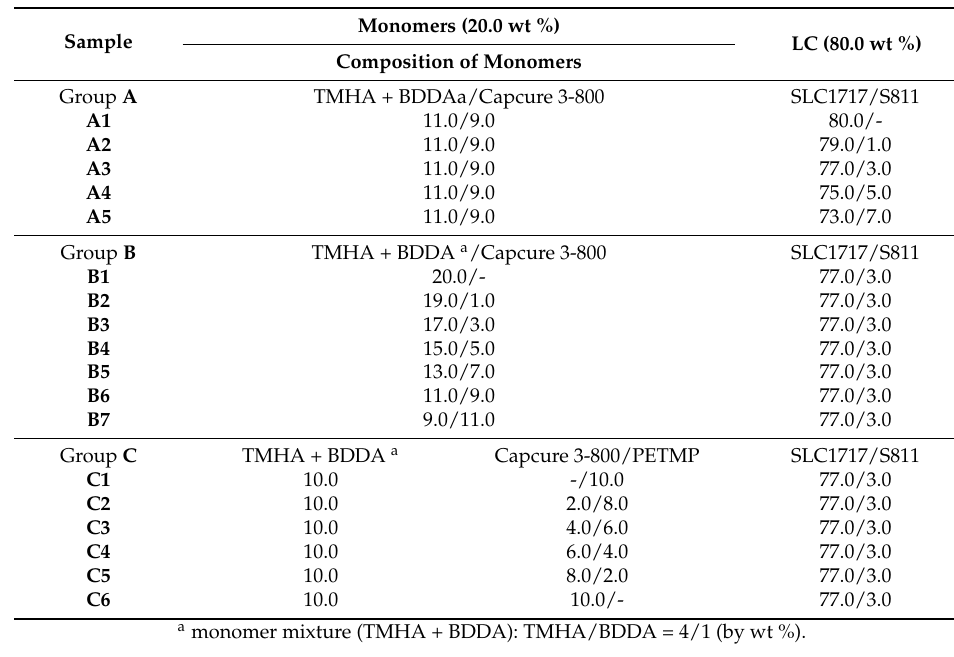
Table 1. The compositions of samples.